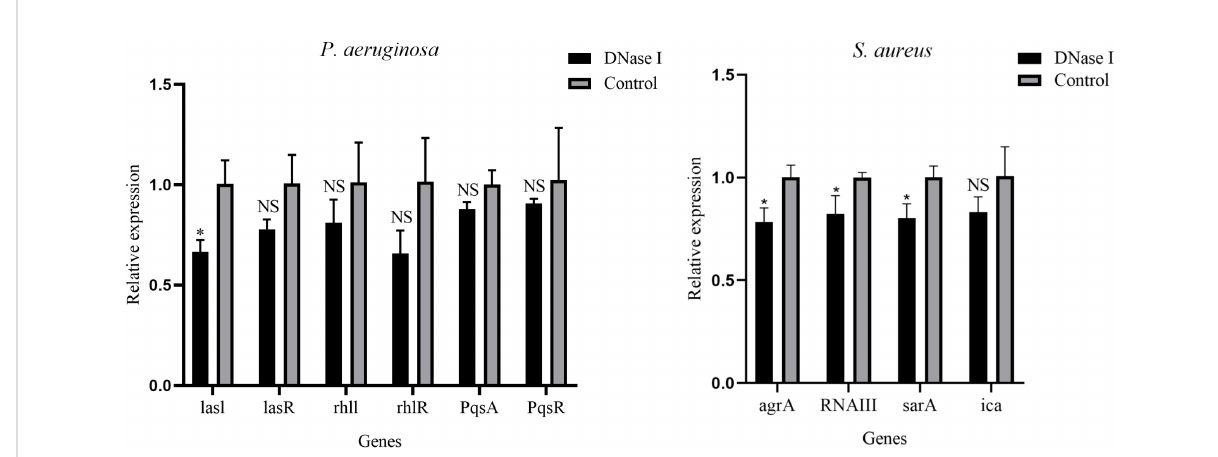
FIGURE 5 Relative expression levels of QS system-related genes of P. aeruginosa and S. aureus in the presence or absence of DNase I, as determined using real-time polymerase chain reaction. The data are presented as mean ± SD. An asterisk indicates a signi fi cant difference; * indicates p < 0.05 and NS indicates p- values > 0.05, compared with the expression values in the drug-free control group using t -tests (n =